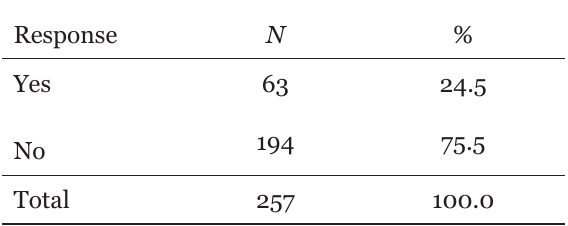
Lecturer Opinion on the Consistency of ODeL Delivery across Geographical Locations